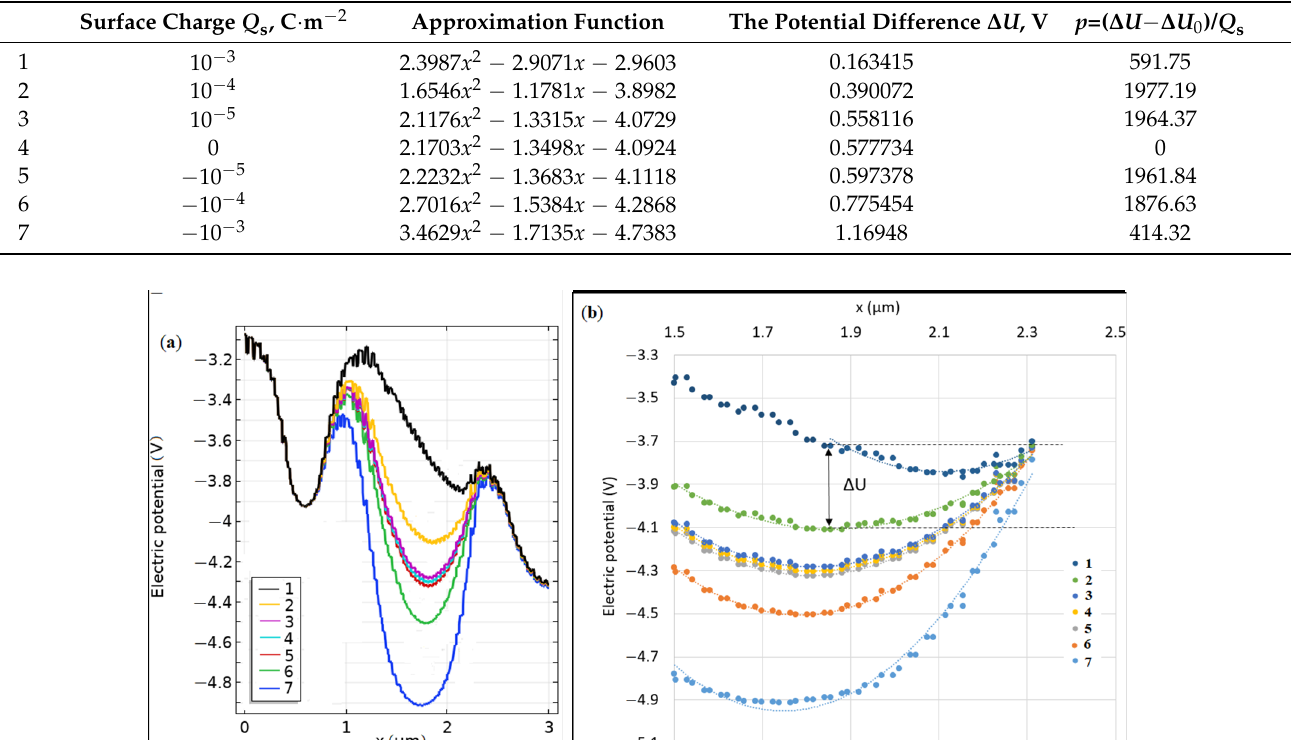
Table 1. Surface charge values and corresponding approximation functions for the potential shift.